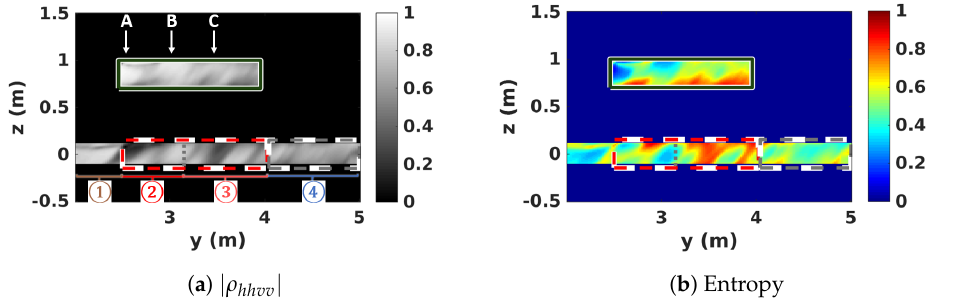
Figure 16. Polarimetric features of VoG tomographic profile.